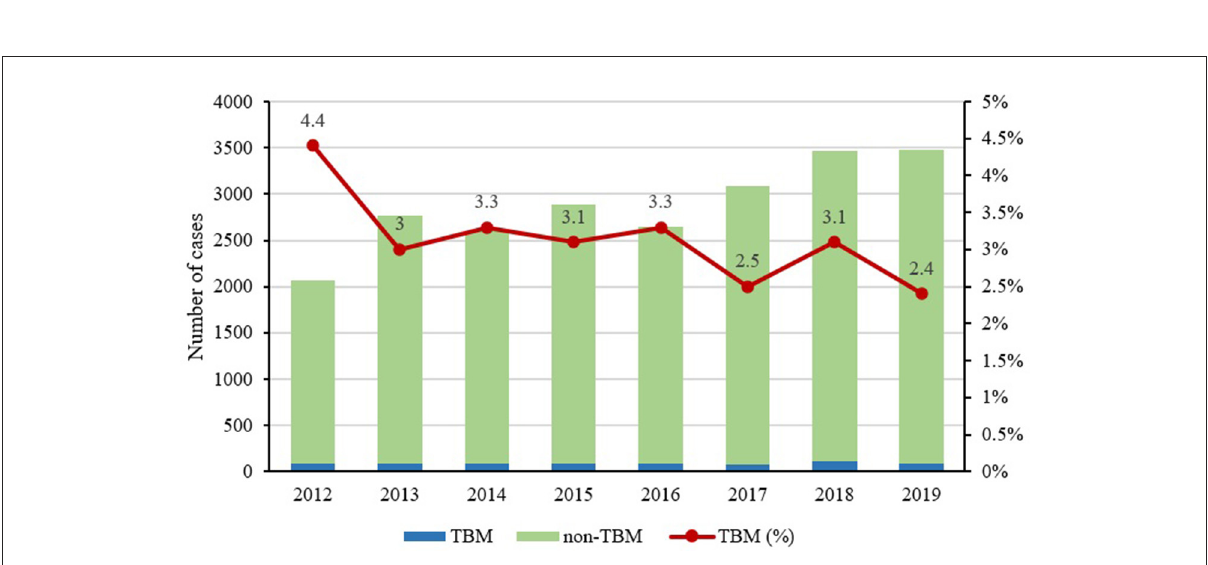
FIGURE2 Proportion of tuberculosis (TB) and tuberculous meningitis (TBM) from 2012 to 2019.